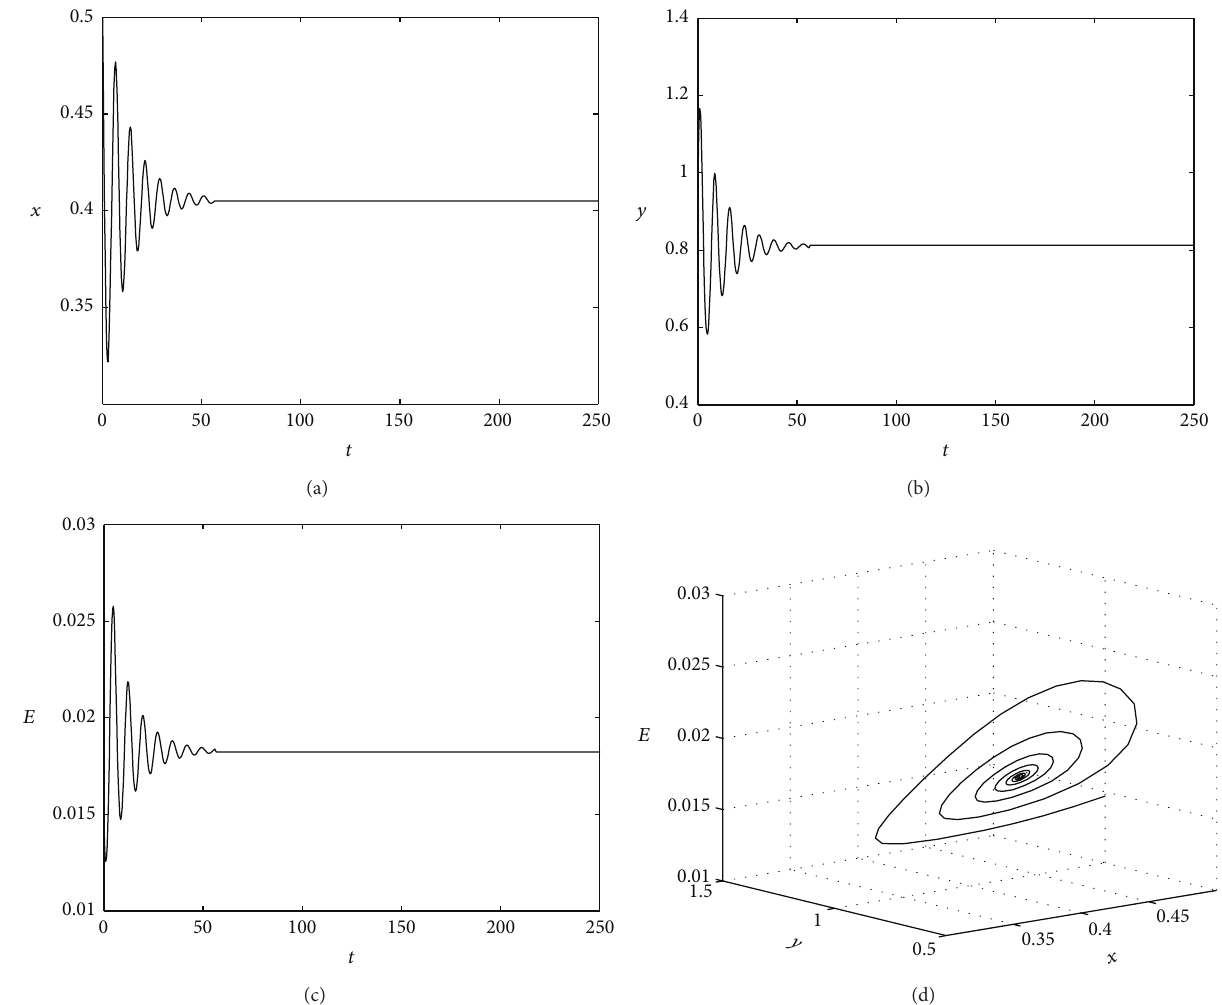
Figure 1: Without any time delay, the positive equilibrium point 𝑃 0 is asymptotically